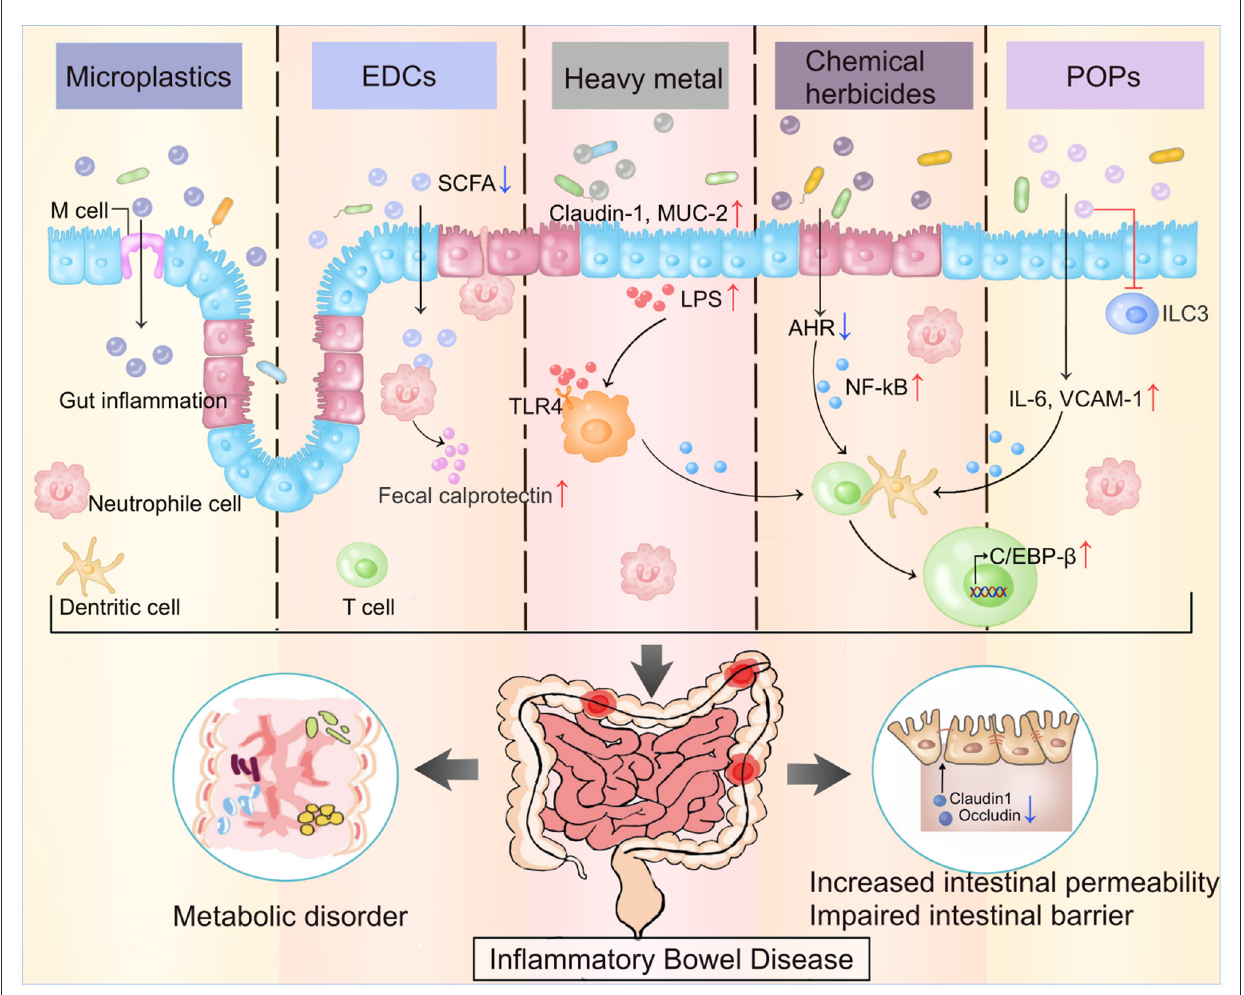
FIGURE2 The main ECs and their impacts on gut microenvironment. ECs damage the intestine by regulating the intensity of immune response, releasing proinflammatory factors, impairing the intestinal barrier, and increasing the intestinal permeability through various mechanism. The figure illustrates the potential mechanism of five ECs mentioned in the review. ECs, Emerging contaminants; EDCs, Endocrine-disrupting chemicals; POPs, Persistent organic pollutants; SCFA, Short-chain fatty acid; TLR4, Toll-like receptors 4; ILC-3, Innate lymphoid cells; VCAM 1, Vascular cell adhesion molecule